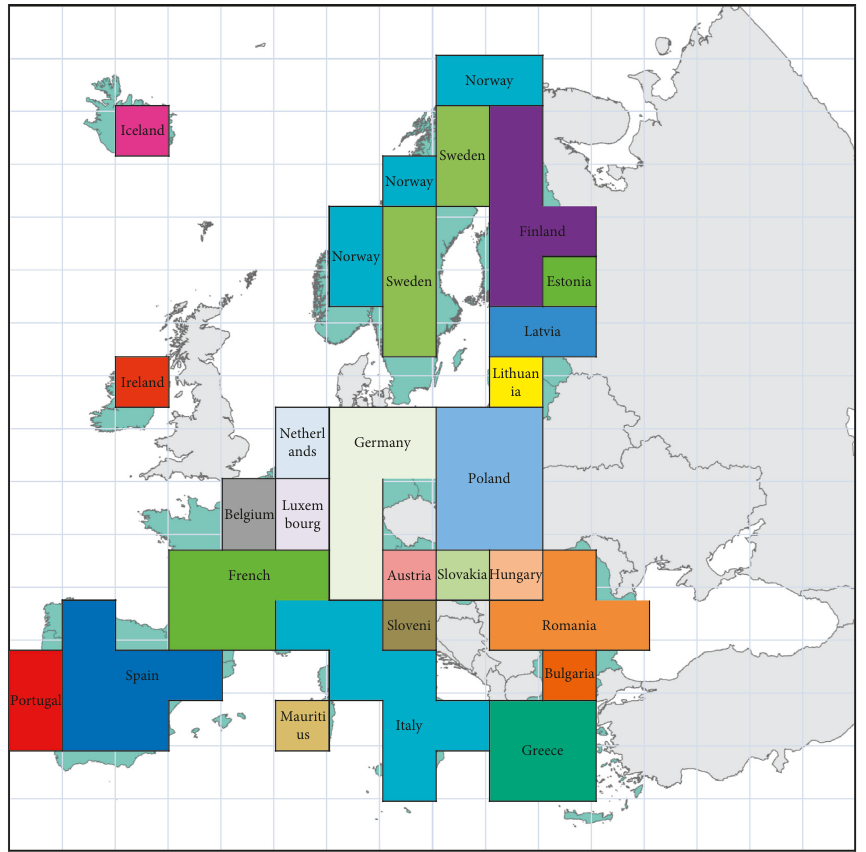
Figure 2: The grid is divided according to the area of the